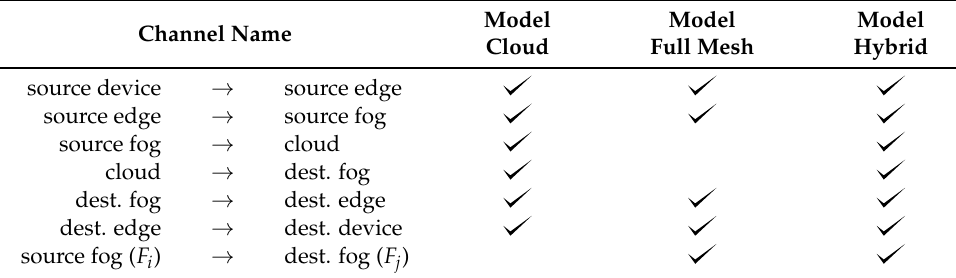
Table 5. Channels defined within the model and their